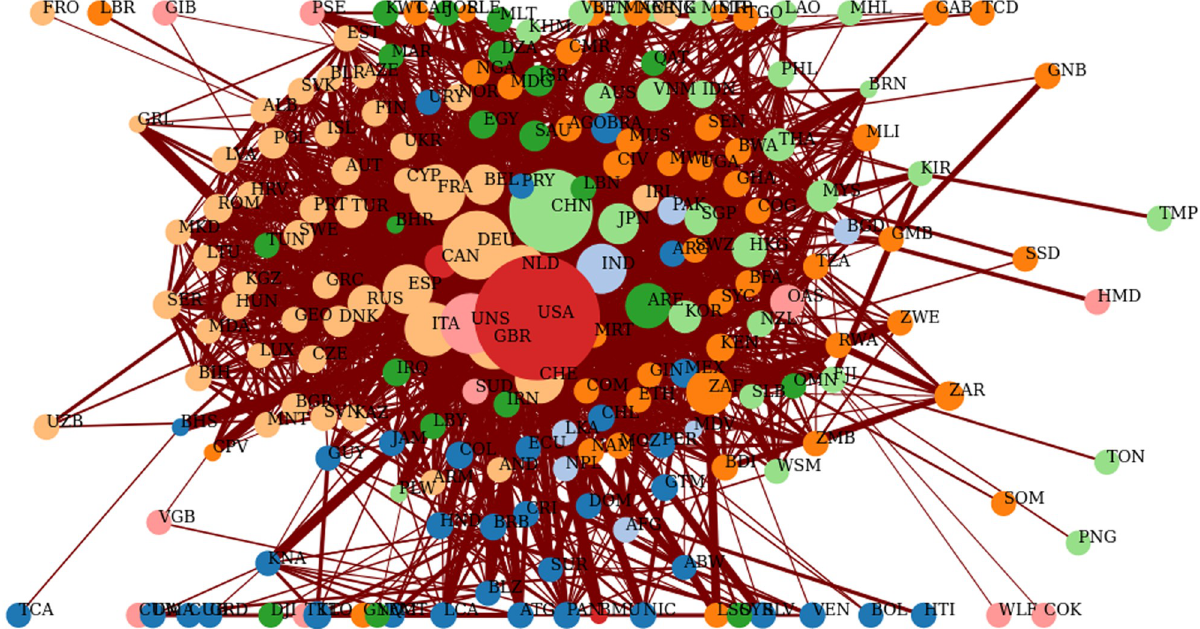
Fig 2. A screenshot of the structure of the WITS total trade network for 2016. Which is the most recent on the site WITS. Link thickness is proportional to country export share while the node size (Weighted in degree) is proportional to the relevance of each country as a buyer in the selected sub-network. Country names are in ISO3 format. This figure is used for the purpose of